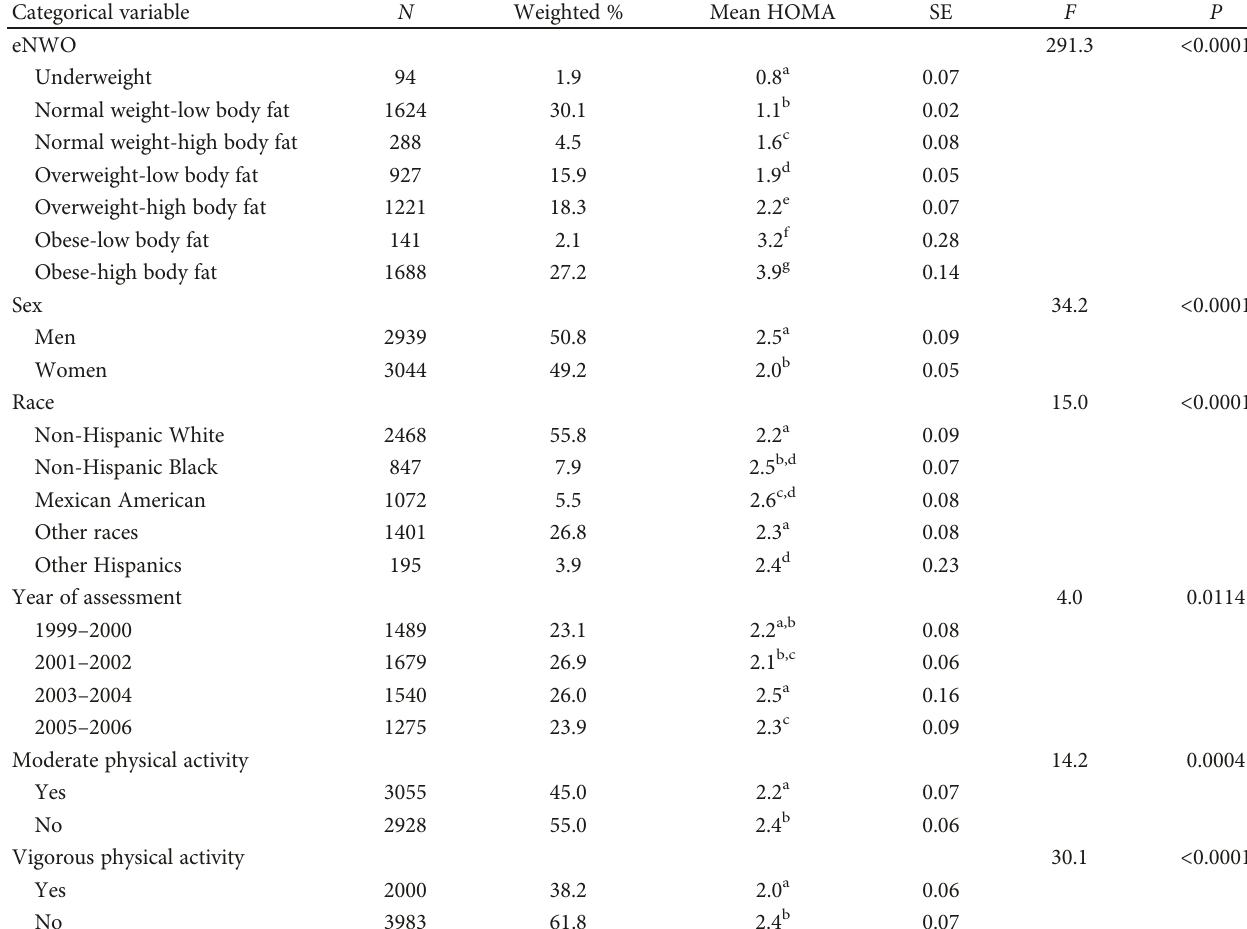
Table 2: Descriptive characteristics of the sample and mean HOMA-IR for each category ( n = 5983 ). Categorical